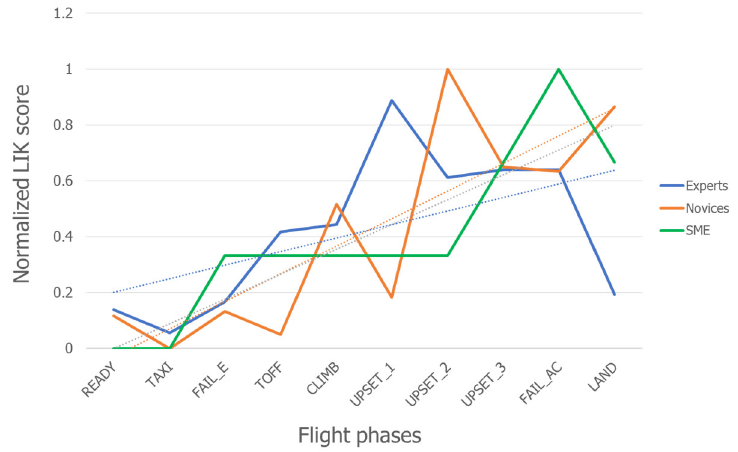
Figure 4. LIK score values throughout the flight phases of the Experts (blue line), Novices (orange line) and SME (green line) related to perceived mental effort demand. The corresponding dotted lines are the interpolated linear trends. Table 1. Results of the Pearson’s correlations analyses on subjective mental effort perceptions.